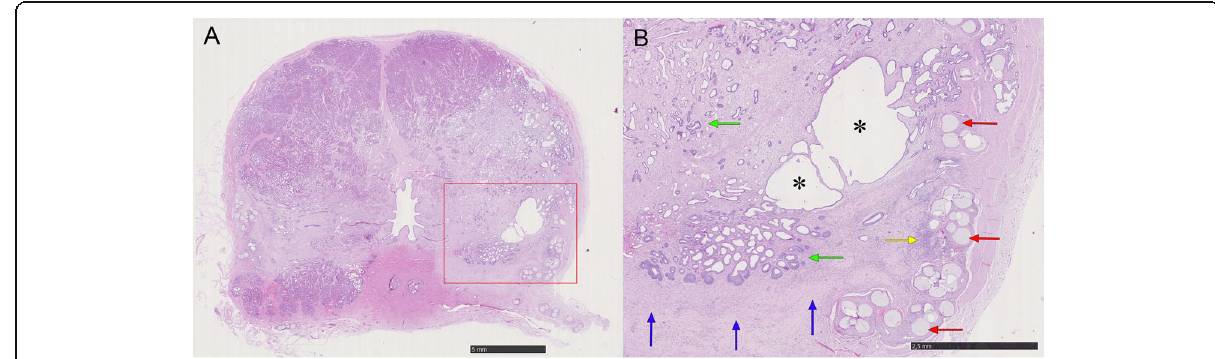
Fig. 5 Microscopic pictures (Hematoxylin & Eosin staining) in the same dog as showed in Fig. 2. a Shows a cavity formation in the left lobe (without magnification). b Shows the low-powered view of the square portion in ( a ). Note the microspheres in the occluded arterioles (red arrows), cavitary formation (asterisks), atrophic residual gland (green arrows), inflammatory cell infiltration (yellow arrow), and diffuse interstitial fibrosis (blue